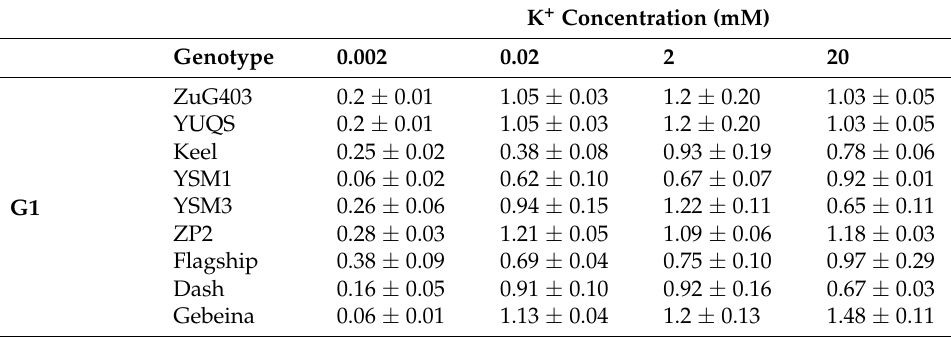
Table 4. Genotypic variation in the grain weight g/plant of barley genotypes under different concentration of K + supply. Values are mean ± SE ( n = 6) and G represents different groups of genotypes. Genotypes have been divided into three group G1, G2 and G3 according to cluster analysis (see Section 3.1 and Figure